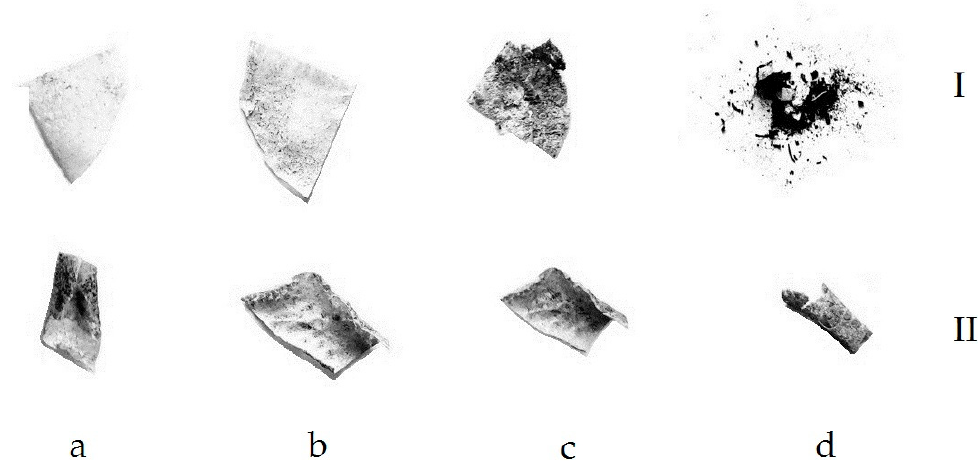
Figure 7. Photographs of PLA-chitosan films (I) and films containing sorbed iron ions (II), after exposition in soil during 2 ( a ), 4 ( b ), 7 ( c ) and 12 ( d ) weeks.